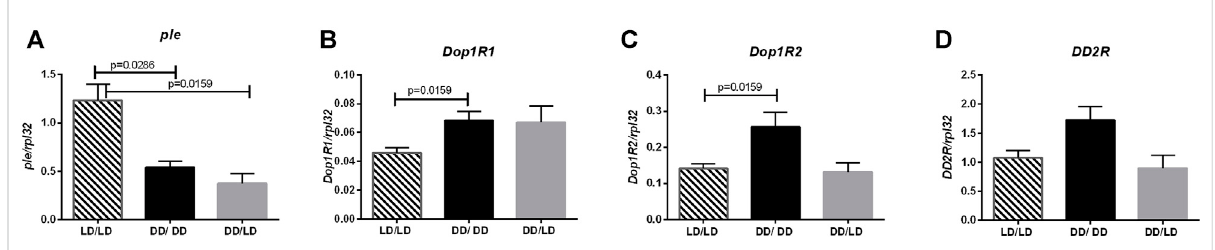
Darkness affects dopamine pathway. qPCR analysis of expression level of genes connected with dopamine signaling for fl ies maintained in normal conditions LD12:12 (LD/LD), maintained in DD (DD/DD) and developed in darkness and after eclosion transferred to LD12:12